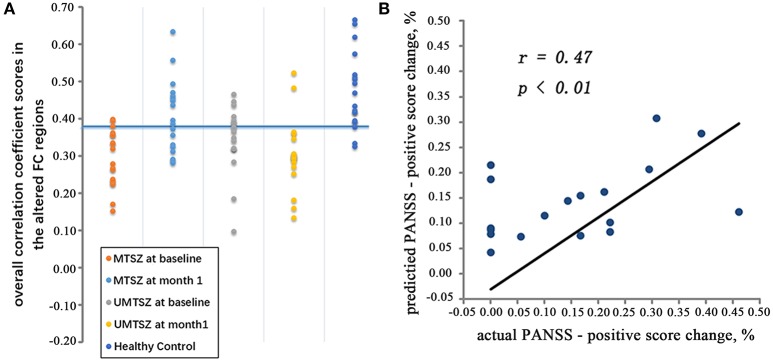
The pattern classification results. (A) Represents the validation result through the machine learning analysis. In the training cohort, the MTSZ at baseline and the MTSZ at 1-month were included. The validation cohort consisted of the UMTSZ at baseline, the UMTSZ at 1-month and the HCs. The blue line indicates a threshold with an 83.3% specificity and a 61.1% sensitivity for differentiating the MTSZ at 1-month from the MTSZ at baseline in the training cohort. Fitting this threshold to the validation cohort provided the accuracy for classifying the UMTSZ at baseline, the UMTSZ at 1-month and the HCs. (B) Represents the prediction result based on the SVR. The scatter map shows a significant correlation between the predicted and true individual percentage of change in the PANSS-positive score.